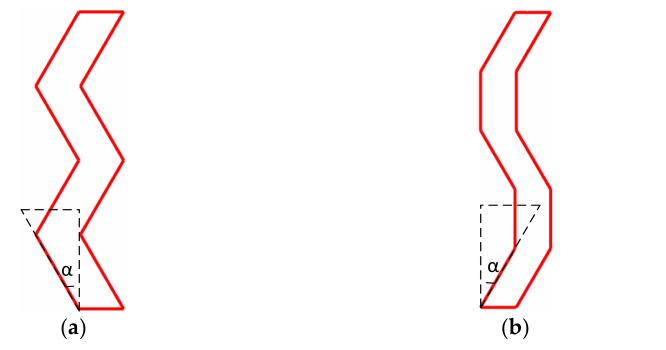
Figure 12. Bend angle for: ( a ) conventional zig-zag channel; ( b ) modified zig-zag channel.